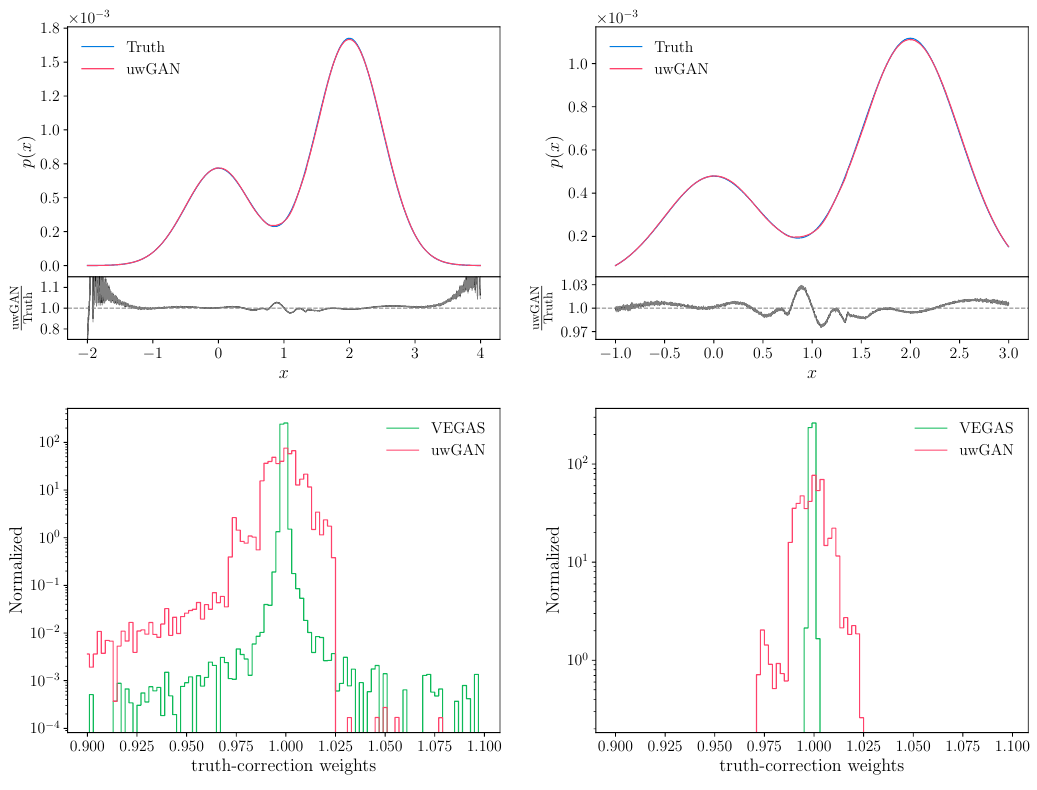
Figure 2: Upper: training and GANned distribution for the 1-dimensional camel back. In the right panels we remove the tails of the distribution. Lower: truth-correction weights for the GANned events, compared with the Vegas weight